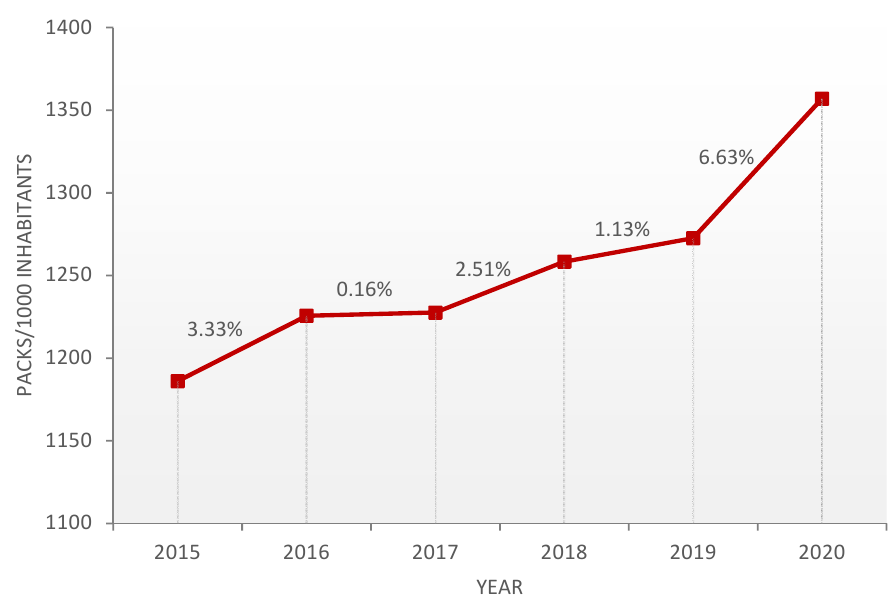
Figure 1. Progression of the consumption of anxiolytics by calculating annual variations.